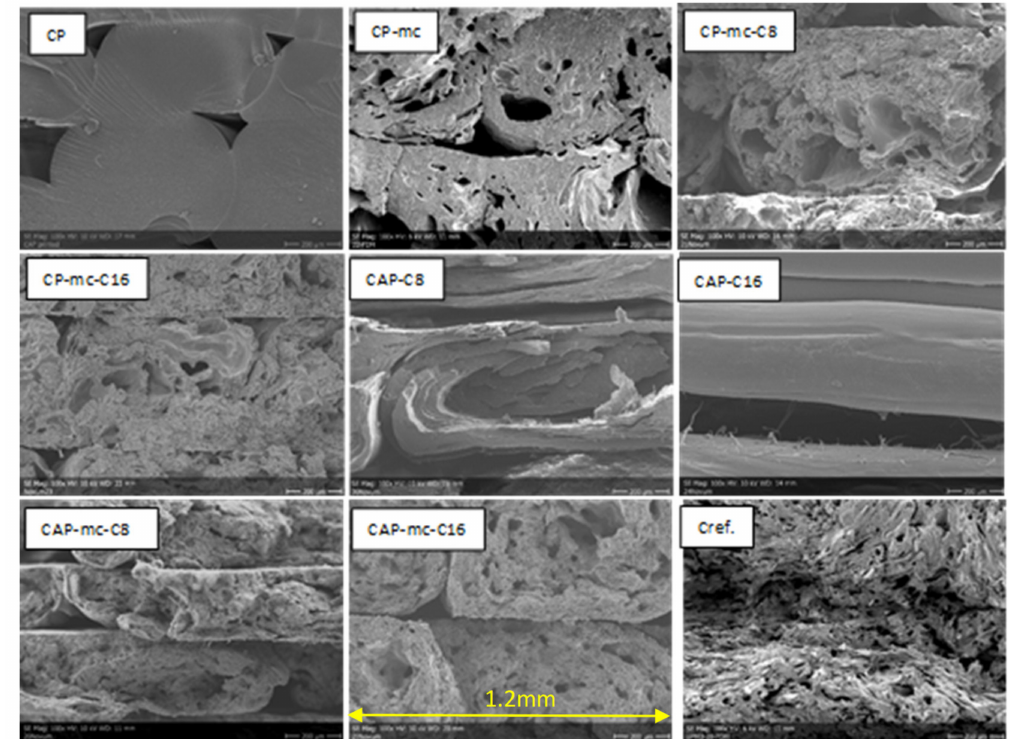
Figure 5. SEM-pictures with 100 × enlargement from the cross-cut of 3D printed test bars. CAP-C16 is from the side of the printed test bar. The width of each pictures is 1.2 mm. CP is commercial cellulose acetate propionate with 13% commercial plasticizer; CP-mc is 20% microcellulose containing CP; CP-mc-C8 contains also 4% cellulose octanoate C8; CP-mc-C16 contains 4% of cellulose palmitate C16; CAP-C8 contains neat cellulose acetate propionate (CAP) with 17% C8; CAP-C16 contain 17% C16 in CAP; CAP-mc-C8 contains 20% mc and 17% C8 in CAP; CAP-mc-C16 contains 20% mc and 17% C16 in CAP and Cref is PLA-based material with 20% cellulose